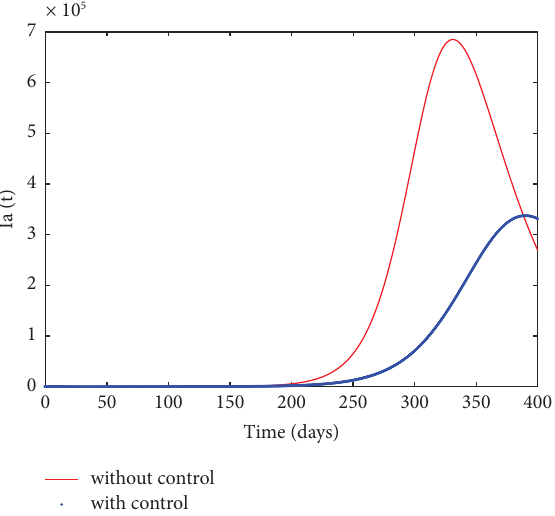
Figure 18: Behaviour of the asymptomatic individuals with and without the vaccination